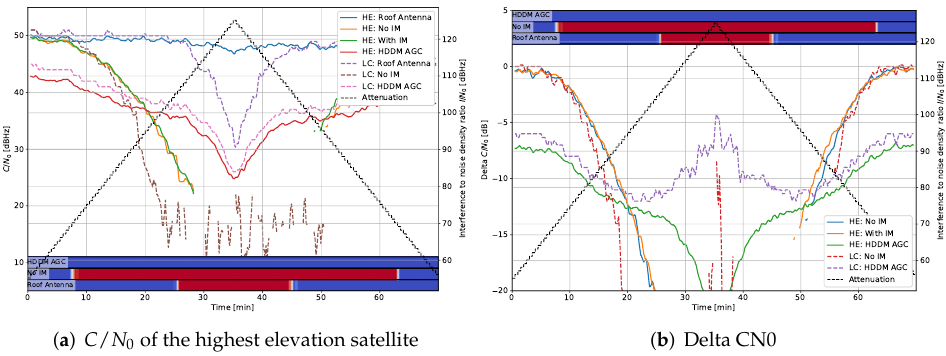
Figure A8. Interference #8: Filtered pulsed noise with 35MHz bandwidth, 50% duty cycle, and 1ms pulse width with GPS L1/CA.